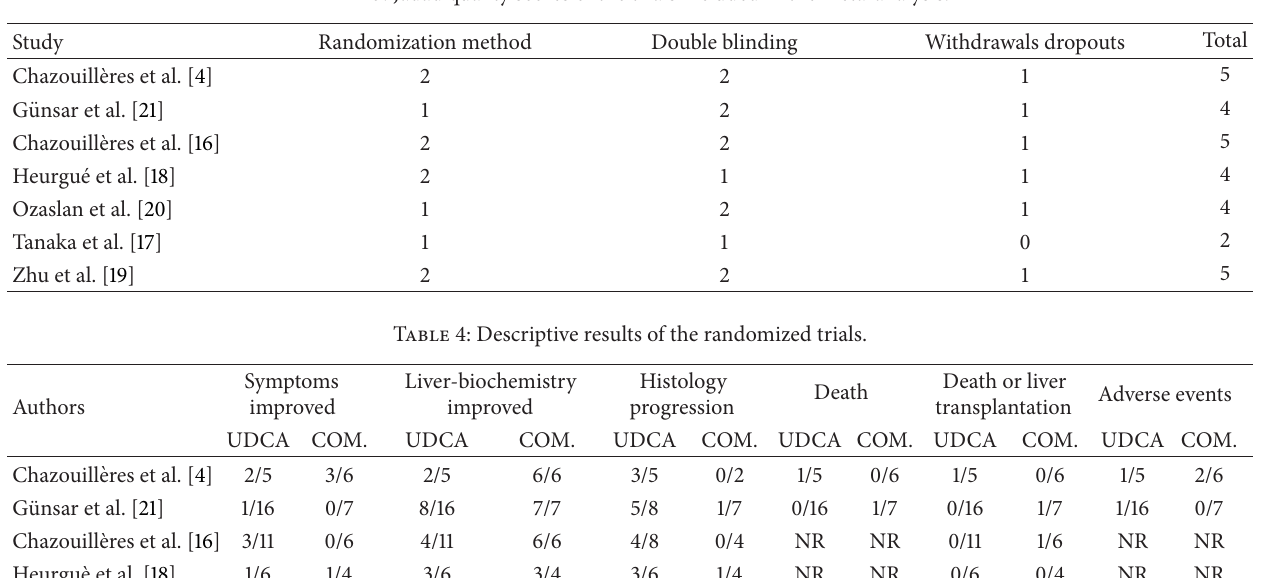
Table 3: Jadad quality scores of the trials included in the meta-analysis.